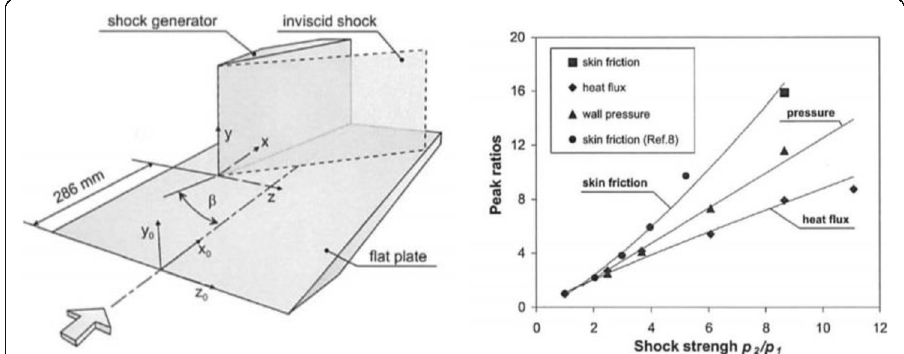
Fig. 5 a Arrangement used to create the swept fin, three-dimensional interactions. b Peak ratios of skin friction, heat flux, and wall static pressure as they varied with inviscid shock wave strength, for primary flow attachment line locations